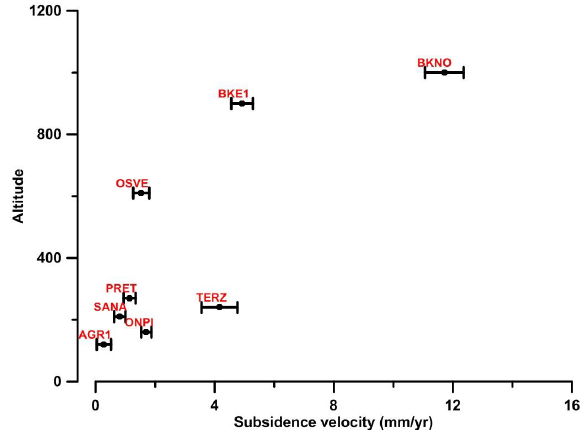
Figure 3. Altitude of GPS stations versus subsidence velocity.